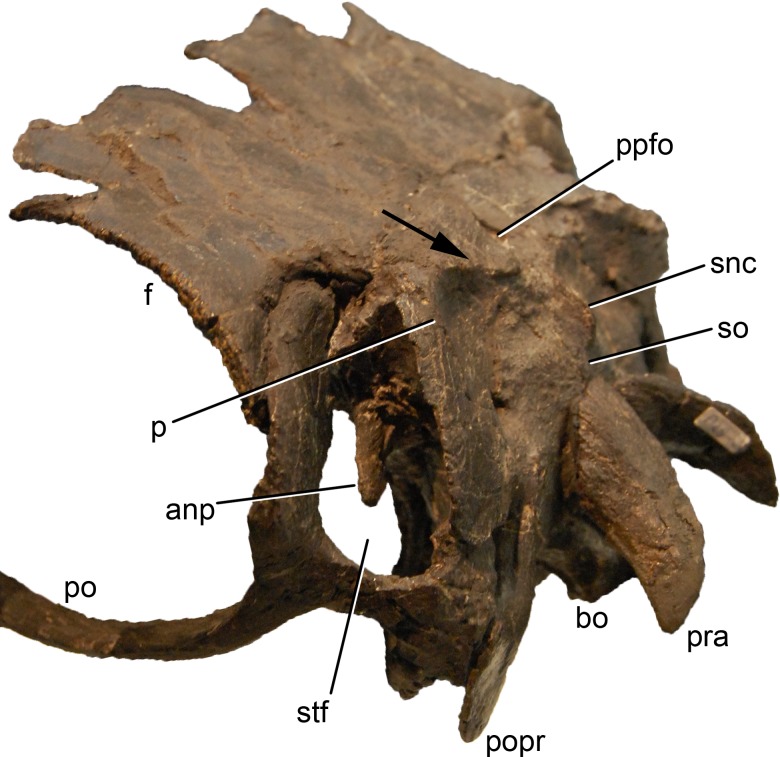
Skull of Kaatedocus siberi SMA 0004 in posterolateral view.Note the transverse ridge of the parietal (arrow, C65-1). Abb.: anp, antotic process; bo, basioccipital; f, frontal; p, parietal; po, postorbital; popr, paroccipital process; ppfo, postparietal foramen; pra, proatlas; snc, sagittal nuchal crest; so, supraoccipital; stf, supratemporal fenestra.